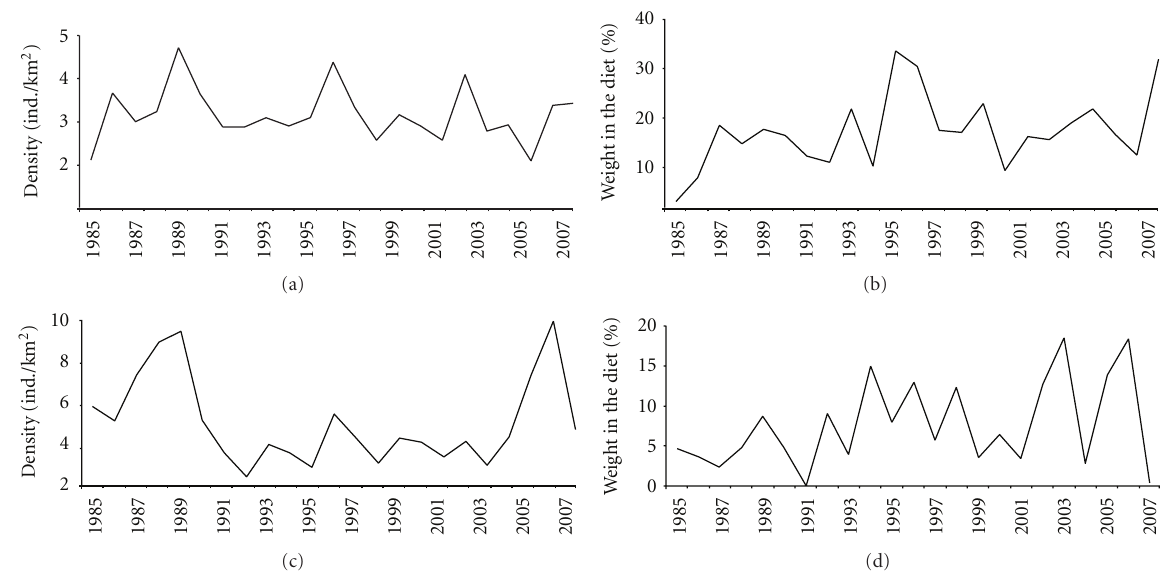
Figure 1: Density of the black grouse hens in August counts (a), weight proportions, hens in the diet of the goshawk (b), density of black grouse chicks in August counts (c), weight proportions of chicks in the diet of the goshawk (d) in South Ostrobothnia and Oulu regions during